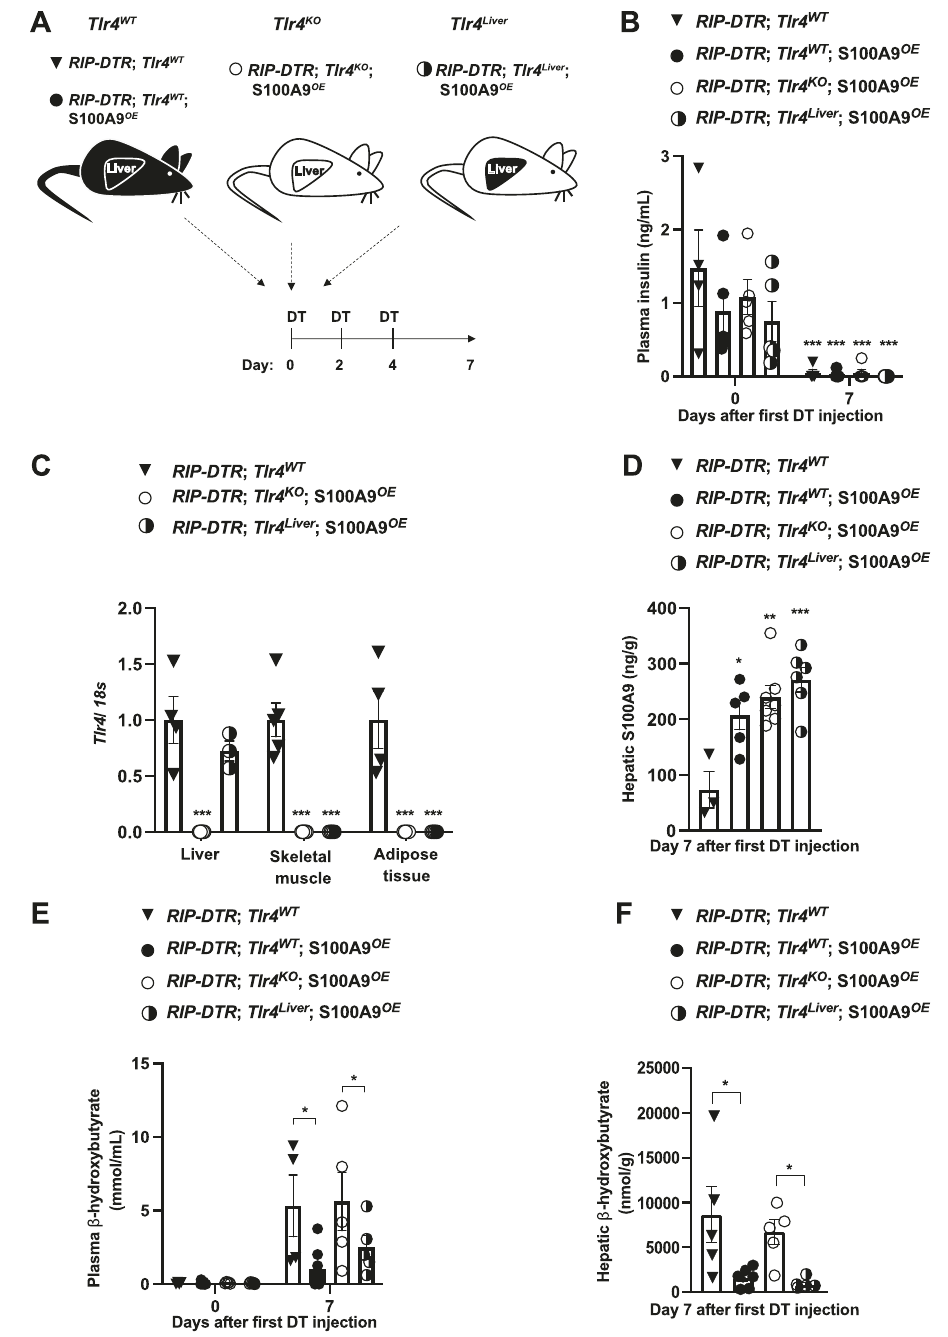
Fig. 1 S100A9 suppresses diabetic ketogenesis via hepatic TLR4. A Scheme indicating the generation of RIP-DTR; Tlr4 WT ( n = 5), RIP-DTR; Tlr4 WT ; S100A9 OE ( n = 6), RIP-DTR; Tlr4 KO ; S100A9 OE ( n = 7) and RIP-DTR; Tlr4 Liver ; S100A9 OE ( n = 6) experimental groups. Adenoviral injections and HTVI were done 3 days before or the same day of the fi rst DT injection, respectively. B Plasma insulin levels of mice at day 0 (i.e., before DT injection) and 7 days after fi rst DT injection ( p = 0.001). C mRNA content of Tlr4 in the liver, muscle (gastrocnemius), and adipose tissue (interscapular brown adipose tissue) of indicated groups ( p = 0.001). D Hepatic S100A9 content of indicated cohorts 7 days after fi rst DT injection ( p = 0.011, p = 0.001 & p = 0.0003). E Plasmatic hepatic β -hydroxybutyrate levels in the indicated cohorts and time after fi rst DT injection ( p = 0.017 and p = 0.012) and F hepatic β - hydroxybutyrate levels in the indicated cohorts and time after fi rst DT injection ( p = 0.03, p = 0.003). Error bars represent SEM, statistical analyses were done using one-way or two-way ANOVA (Tukey ’ s post- hoc test). In B , comparison was made to basal values. In C – F comparison was made to RIP-DTR; Tlr4 WT group or otherwise indicated. * p ≤ 0.05, ** p ≤ 0.01, *** p ≤ 0.001. Source data are provided as a source data fi S100A9 suppresses diabetic ketogenesis by activating hepatic tissue lipase activity was observed between ID groups (Supple- mTORC1 via TLR4 . The aforementioned data revealed a key mentary Fig. 1K). Collectively, these data demonstrate that hepatic TLR4 is suf fi cient for mediating the ketogenesis-lowering action of role of hepatic S100A9-TLR4 axis in suppressing pathological S100A9 in diabetic mice. ketogenesis; yet, the identity of the downstream intracellular